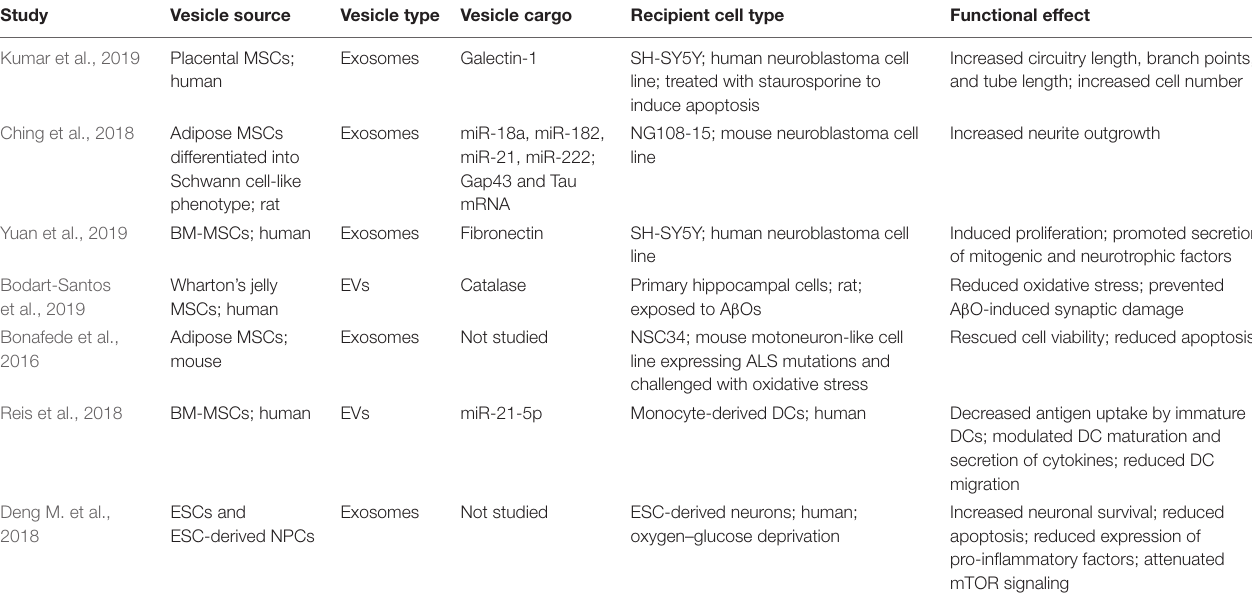
TABLE 1 | In vitro studies using stem cell EVs for CNS-related